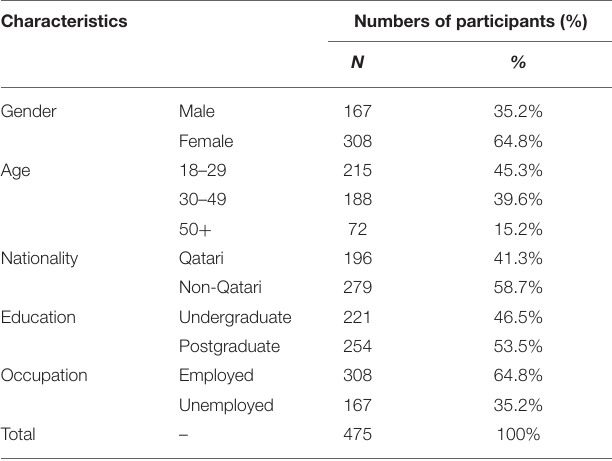
TABLE 1 | Demographic characteristics of the subjects included in this